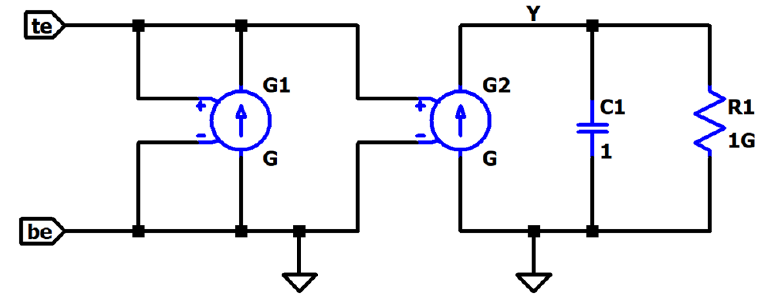
Figure 2. An equivalent schematic of a memristor model in the LTSPICE environment.